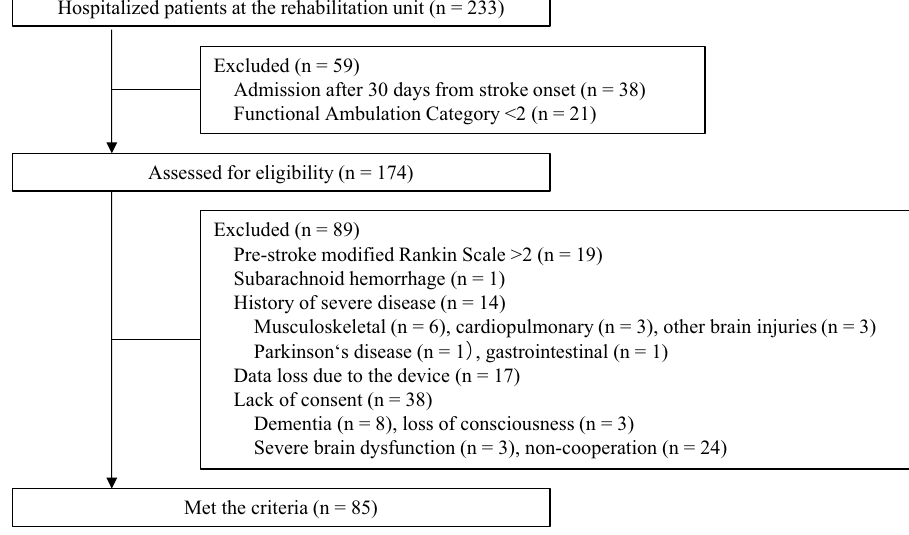
Figure 1. Participant flow in the present